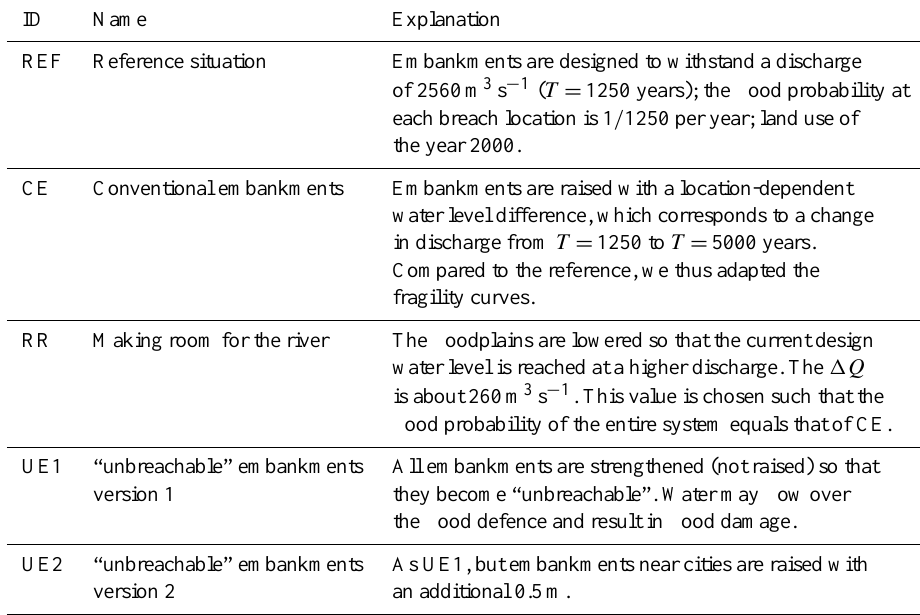
Table 1. Overview of alternative system